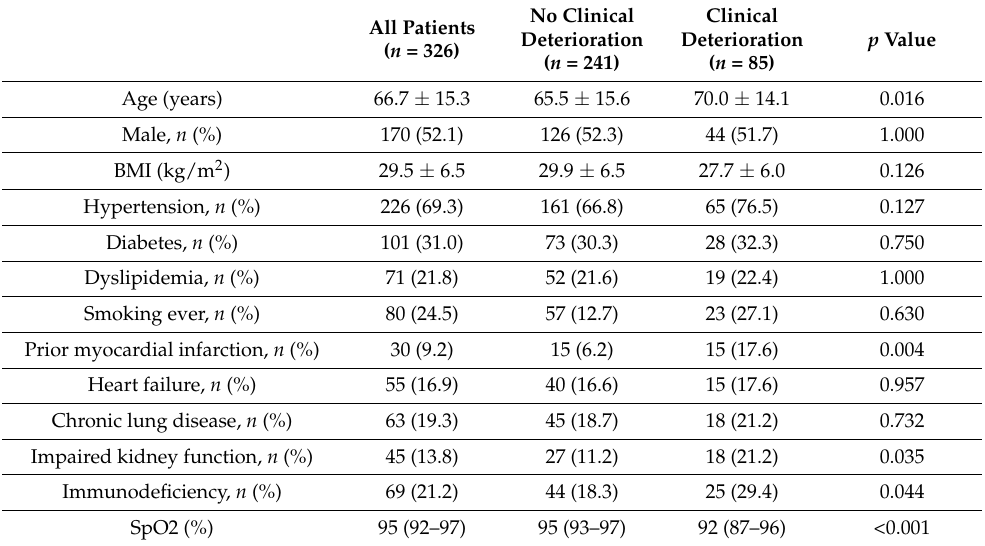
Table 1. Clinical characteristics of patients at the time of